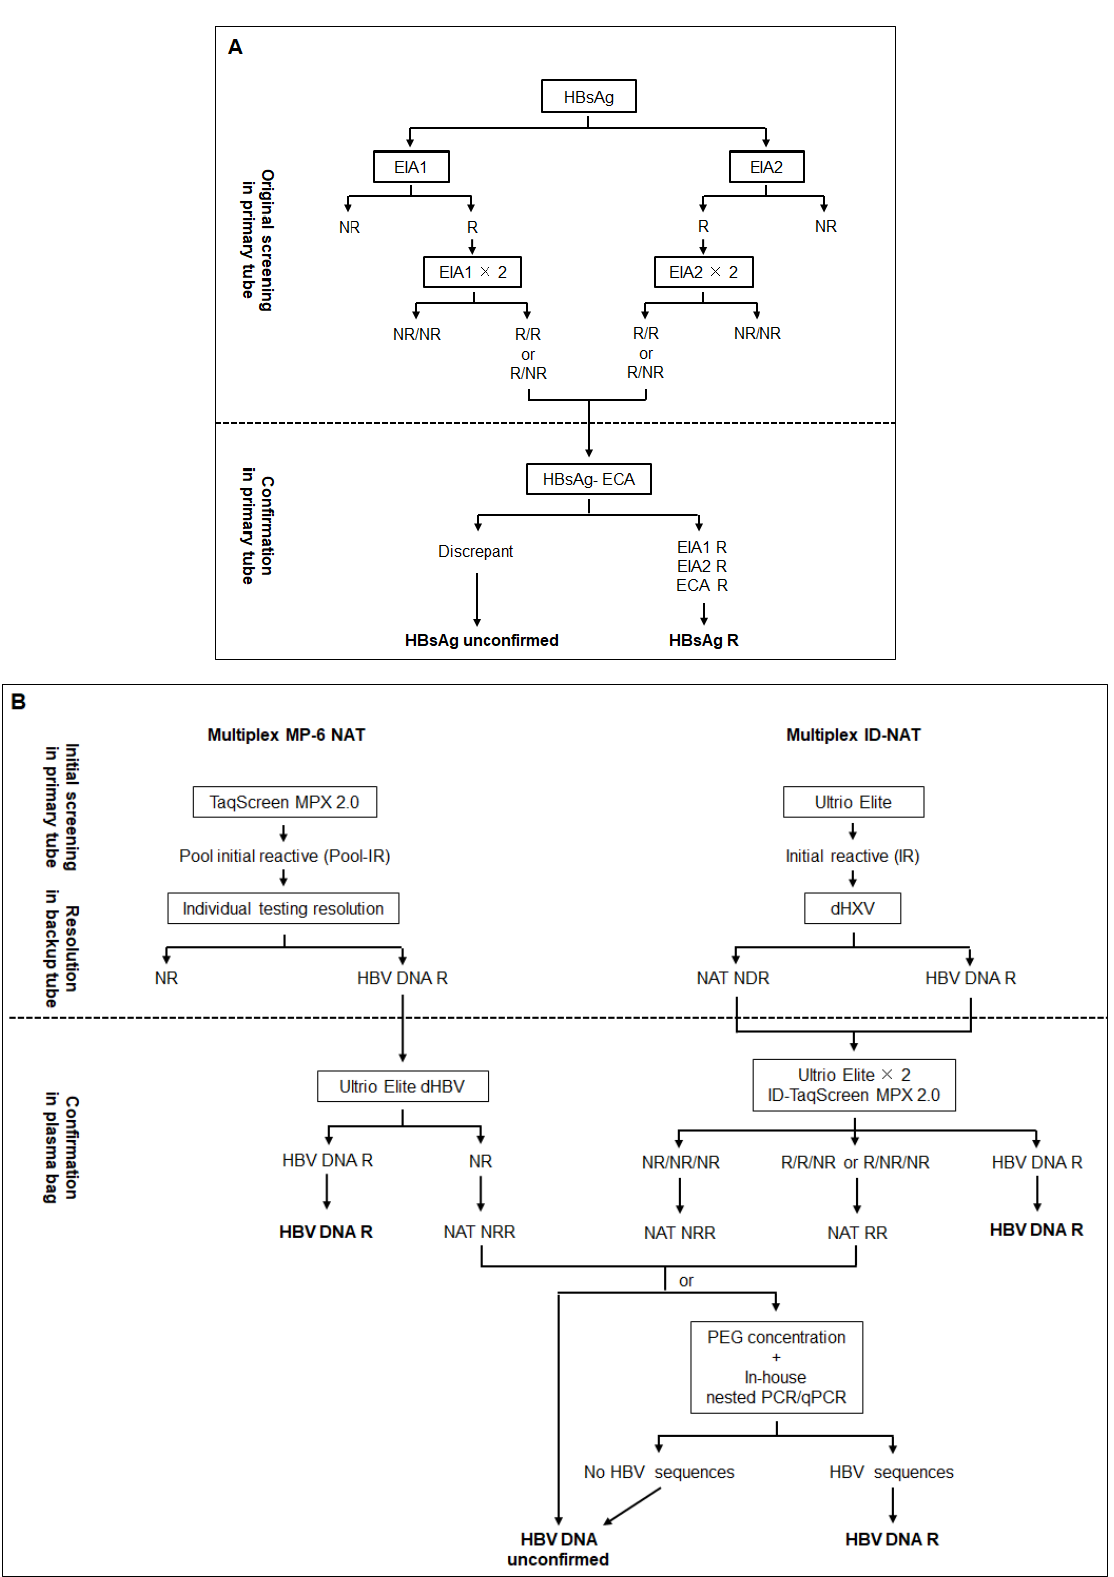
Figure 3. HBsAg ( A ) and HBV NAT ( B ) screening and confirmatory algorithms at Dalian Blood Center.